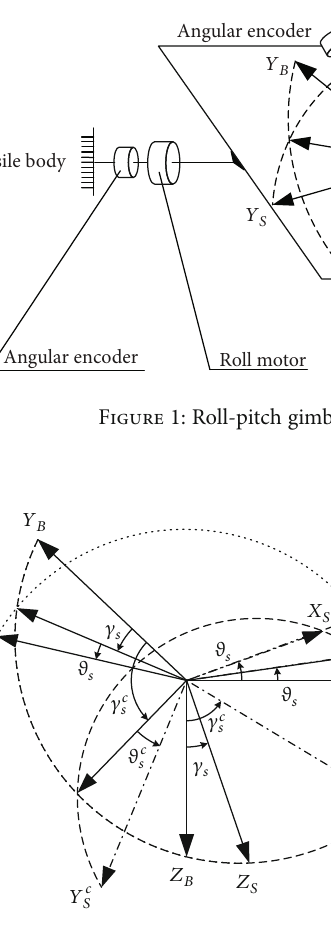
and ϑ are the actual angles s s